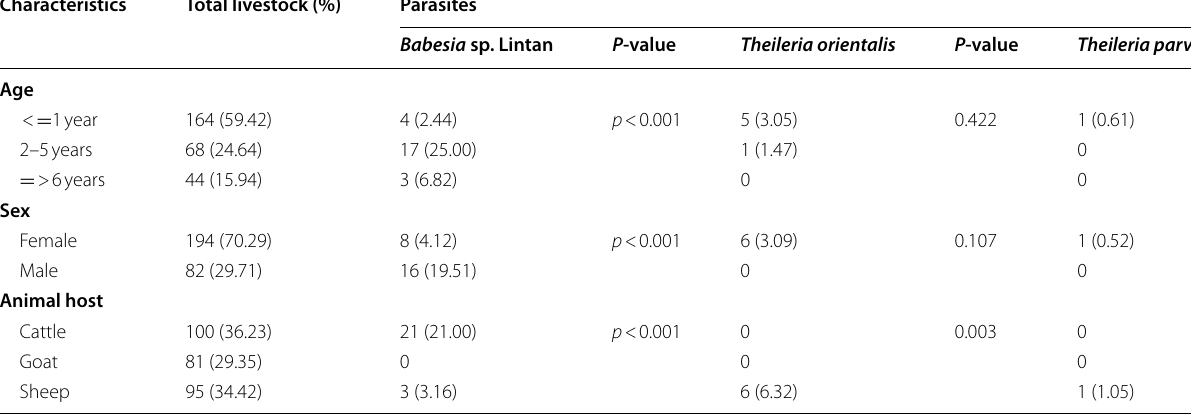
Table 1 Livestock characteristics and parasitic tick‑borne pathogens prevalence